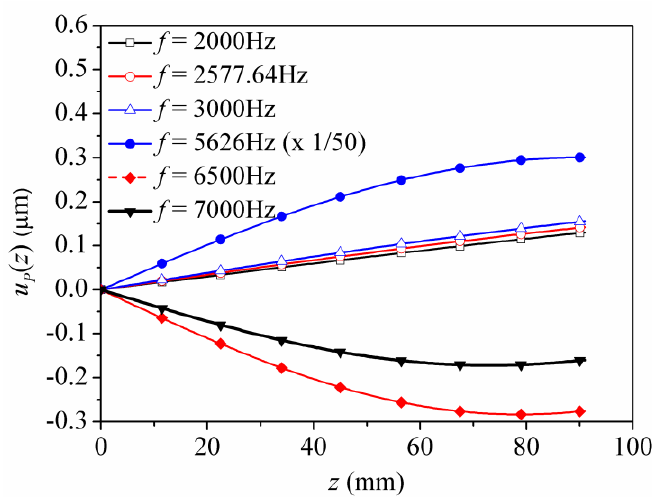
u z along the P